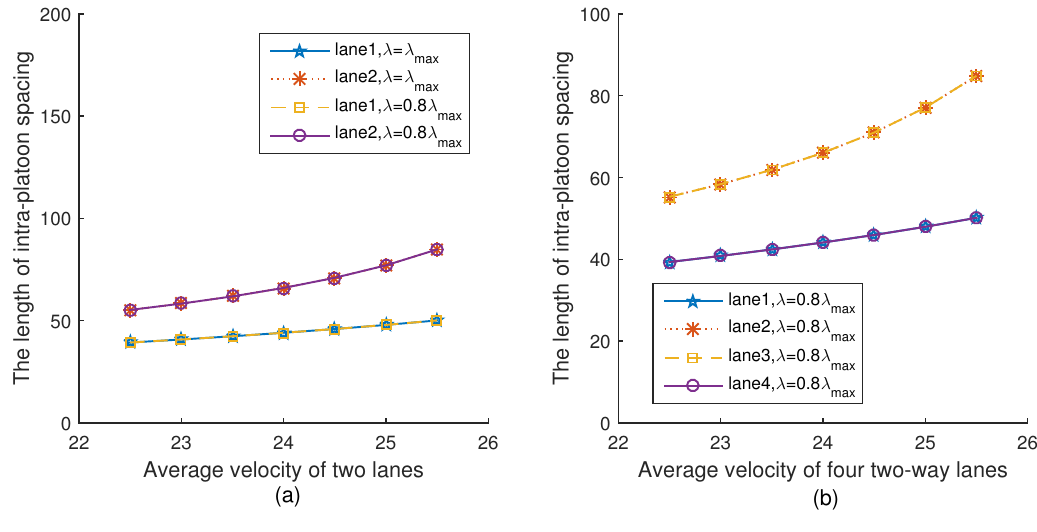
Figure 6. The intra-platoon spacing versus velocity.